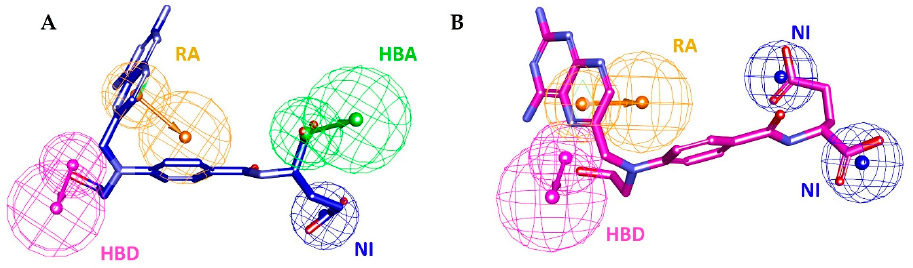
Figure 3. Hit compound (MTX-analog) mapping with pharmacophore models. ( A ) Hit compound represented in dark blue colored thick stick model mapping with WT-pharma. ( B ) Hit compound represented in magenta-colored thick stick model mapping with MT-pharma.